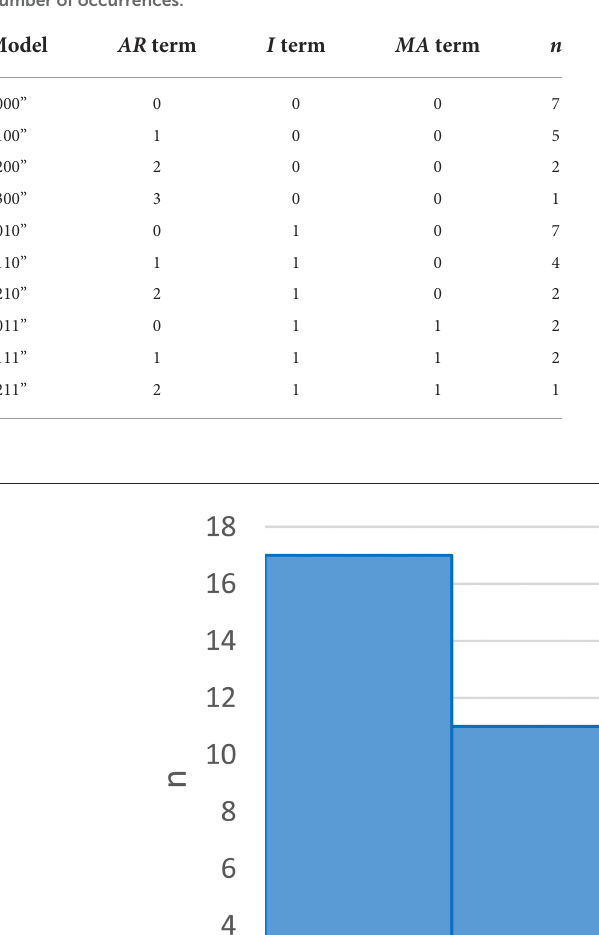
number of occurrences.